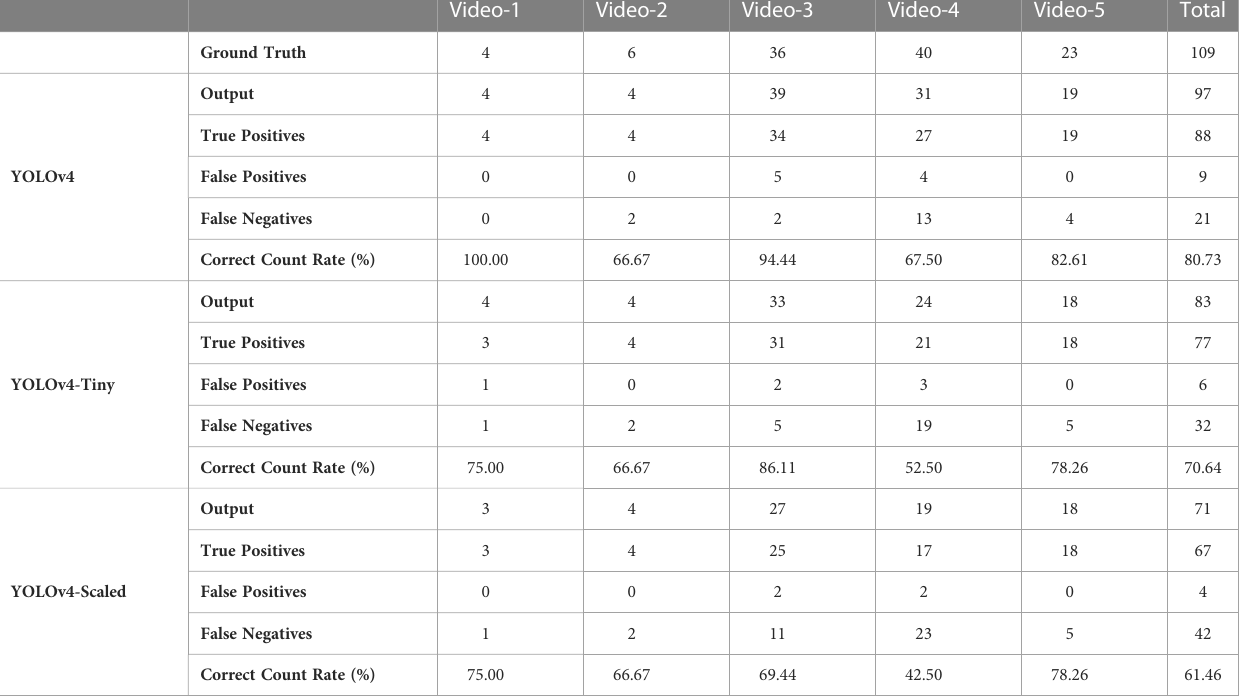
TABLE 5 Detailed numbers of counts obtained by the detection models.